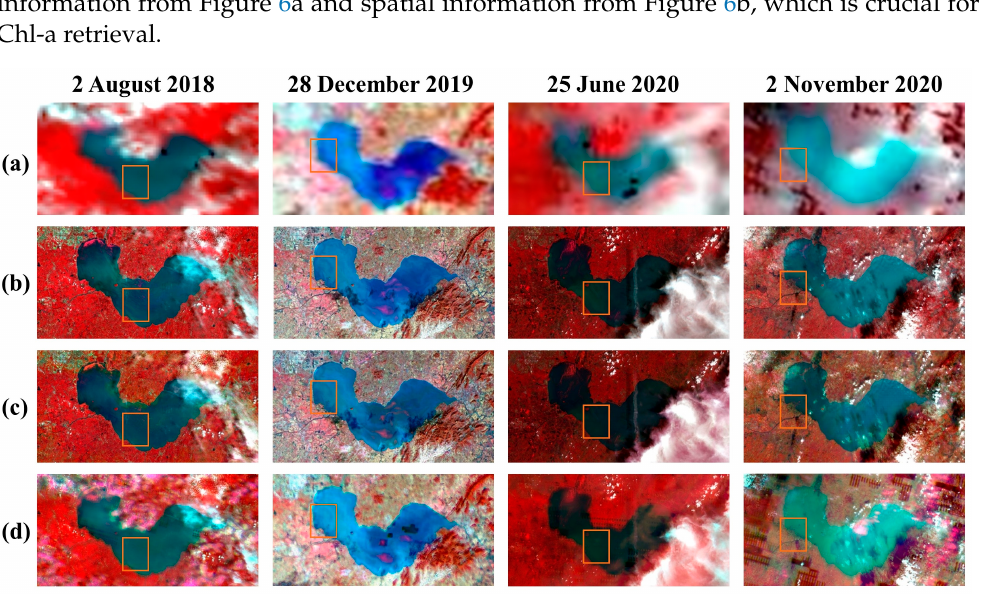
Figure 7. Comparisons of the spatial-spectral correlation coefficient ( (cid:1829)(cid:1829) (cid:3047)(cid:3042)(cid:3039) ) of the fused images with the degradation model (red line) and fused images without the degradation model (blue line) for four dates. ( a ) 2 August 2018; ( b ) 28 December 2019; ( c ) 25 June 2020; ( d ) 2 November 2020. 4.1.2. Spectral Comparisons of Fused and MSI Images To further illustrate the advantages of the fused images obtained via the PSSDFN, we compared the spectral information of the fused and original MSI images. Firstly, we resampled the fused and MSI images to the MODIS scale (i.e., 1 km), and then calculated the spectral correlation of the MODIS images. Figure 8 shows the (cid:1829)(cid:1829) (cid:3046)(cid:3043)(cid:3032) values of the nine fused bands and corresponding original MSI bands at four different dates. Compared to